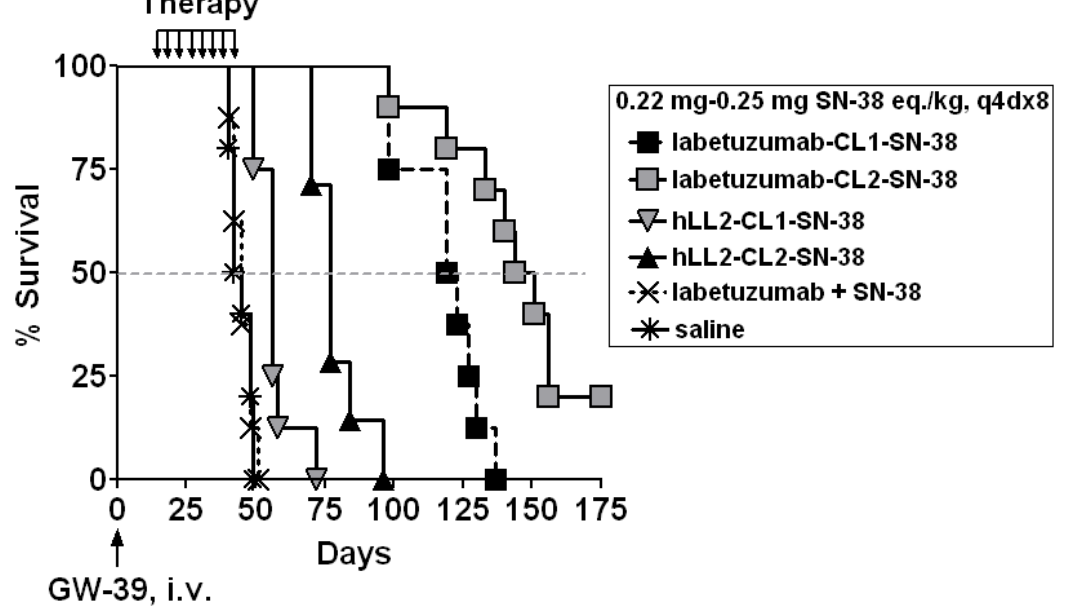
FIGURE 5. In a lung metastatic model of the GW-39 human colon carcinoma in nude mice (n = 7  10), animals were administered CL1-SN-38 or CL2-SN-38 conjugates of specific labetuzumab (hMN-14), respective nonspecific conjugates of epratuzumab (hLL2), and other controls as noted. The dose and dose schedule were 0.22  0.25 mg SN-38 equivalent/kg, twice weekly for 4 weeks. The figure shows Kaplan-Meier survival plots for different treatments. Reproduced from Figure 2B of Govindan et